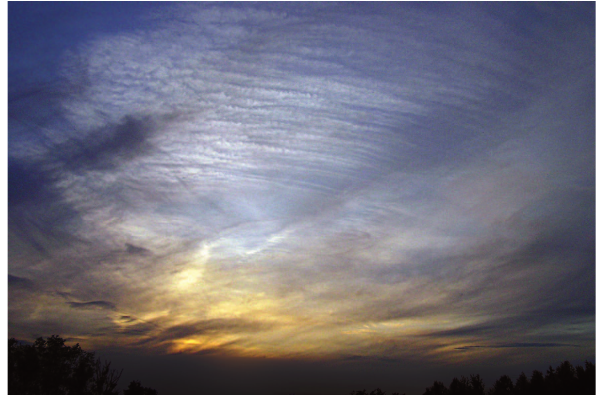
Figure 2. Photograph courtesy of A. O. Andreyev (Andreyev et al., 2007). High-altitude cirrus clouds look like noctilucent clouds in the evening